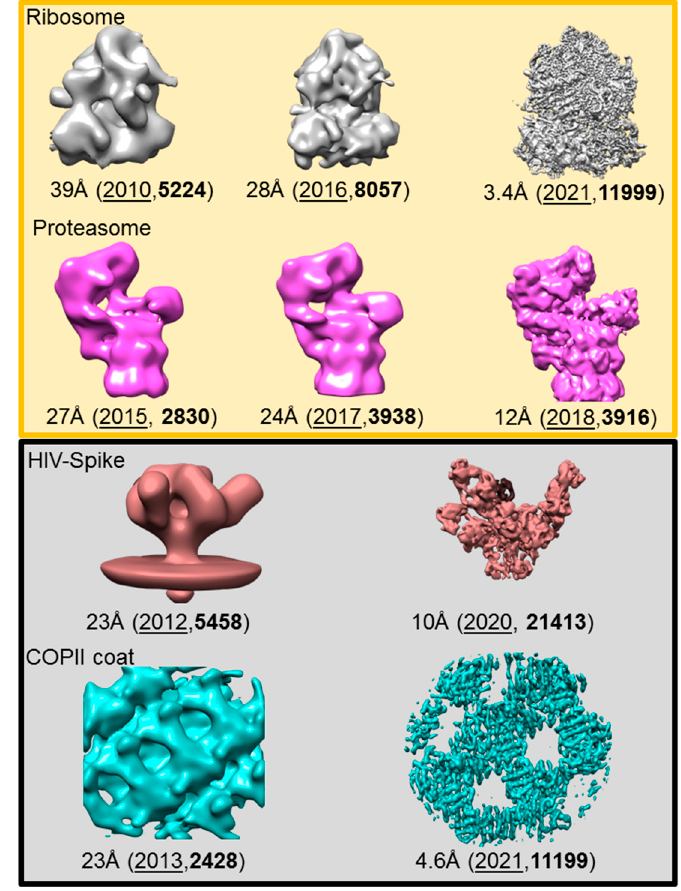
Figure 3. Examples of the improvement in resolution of sub-tomogram averaging maps. The resolution is given for each structure, together with the year (underlined) and the EMDB-ID (bold). The top (yellow panel) shows structures from in situ specimens. The grey box below shows samples that were reconstituted in vitro .